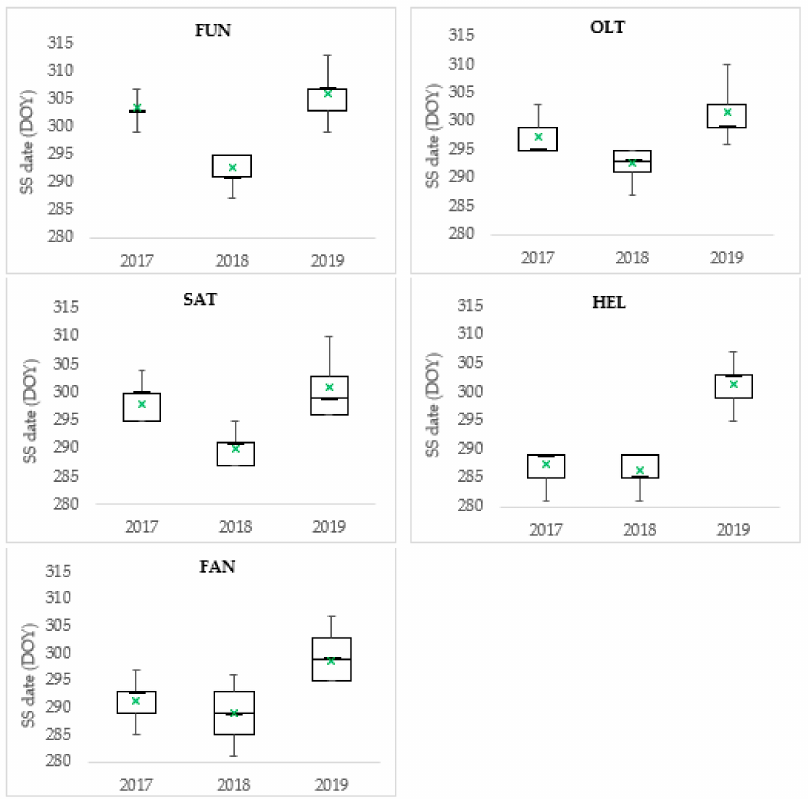
Figure 3. Boxplot diagram of sessile oak senescence phenophase in the studied populations. The bottoms and tops of boxes denote the 25 and 75% quartiles; the bold lines denote the median. The whiskers represent the minimum and the maximum DOY values. The green crosses indicate the mean value across all trees in each